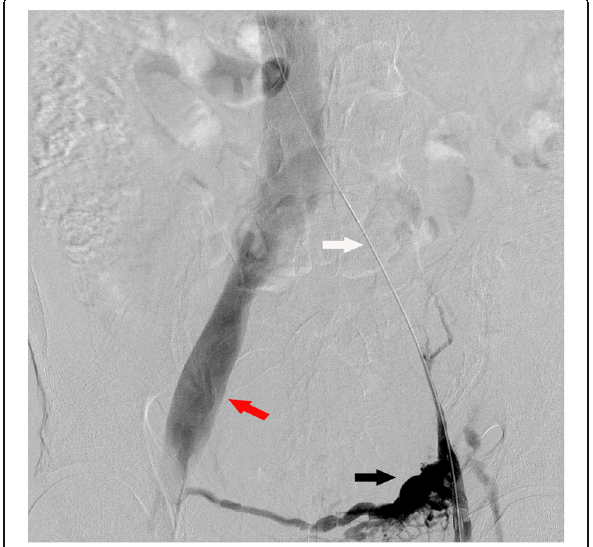
Fig. 2 Digital subtraction venography demonstrating complete occlusion of the left common iliac vein and collateralization. The site of occlusion is identified (white arrow). Contrast injected ipsilateral and distal to the lesions is seen draining to the contralateral common iliac vein (red arrow) through the dominant left-to-right sapheno-saphenous collateral drainage pathway (black arrow)